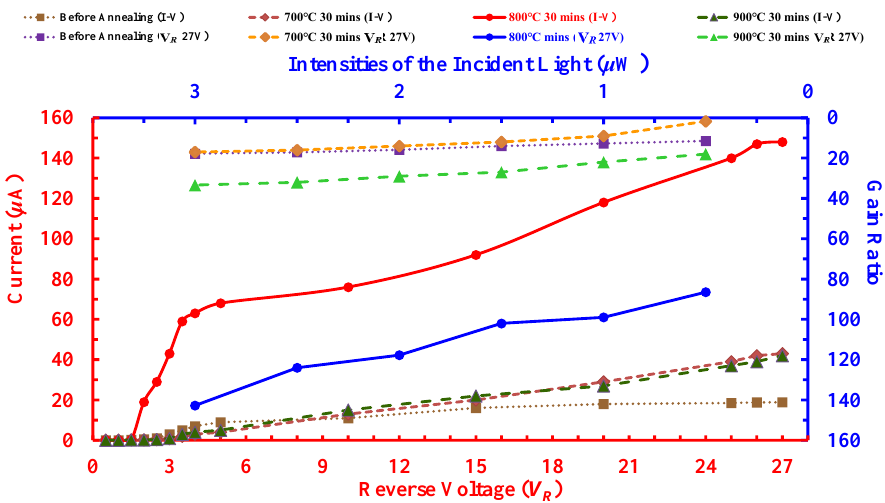
Figure 5. The current-bias voltage (I-V) curves of poly-Si 0.8 Ge 0.2 films under 3- µ W incident light Fig. 5 power (bottom-left axes) and gain ratio curves versus using a reverse bias voltage up to 27 V (top-right Y.-T. Cheng et . al . axes). The APS devices were prepared with as-deposited and annealed poly-Si 0.8 Ge 0.2 films at 700 ◦ C to 900 ◦ C for 30